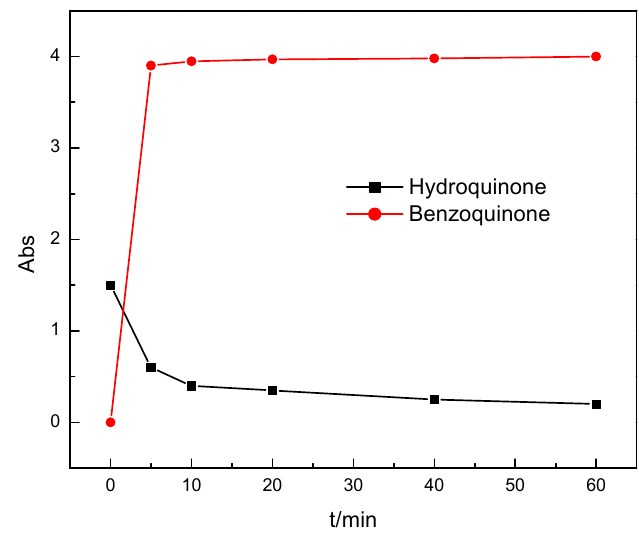
Figure 6. E ff ect of reaction time on the concentration of hydroquinone and Figure 6. Effect of reaction time on the concentration of hydroquinone and benzoquinone.